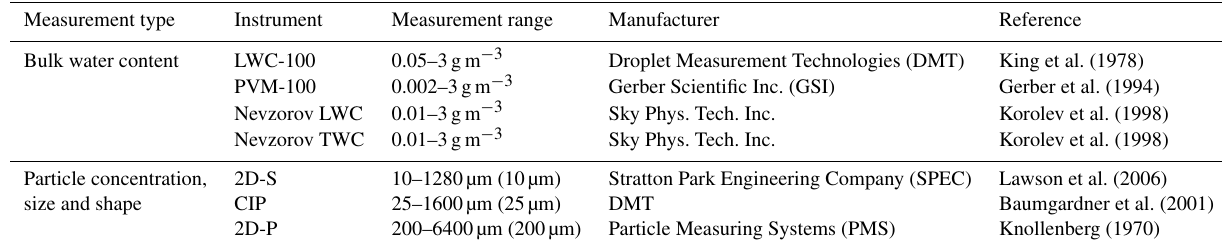
Table 1. Characteristics of UWKA in situ microphysics data used in this study. The measurement range for each instrument is listed. Size resolutions for the 2D-S, CIP and 2D-P instruments are indicated in